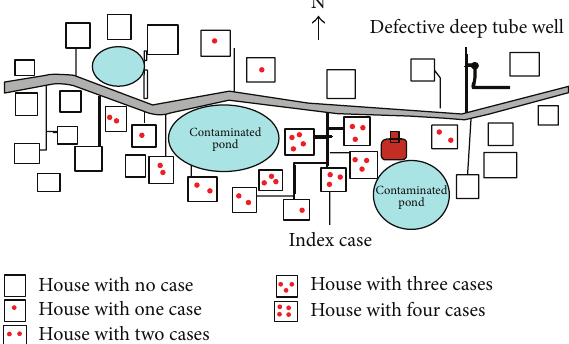
Figure 2: Spot map of diarrhea cases at Haibatpur village, Purba Medinipur district, West Bengal, India,